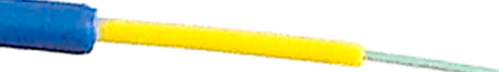
Figure 10. Graphical presentation of possible slippage between the layers: ( a ) stripped three-layer cable; ( b ) the piece of intermediate layer slipped against the internal layer.